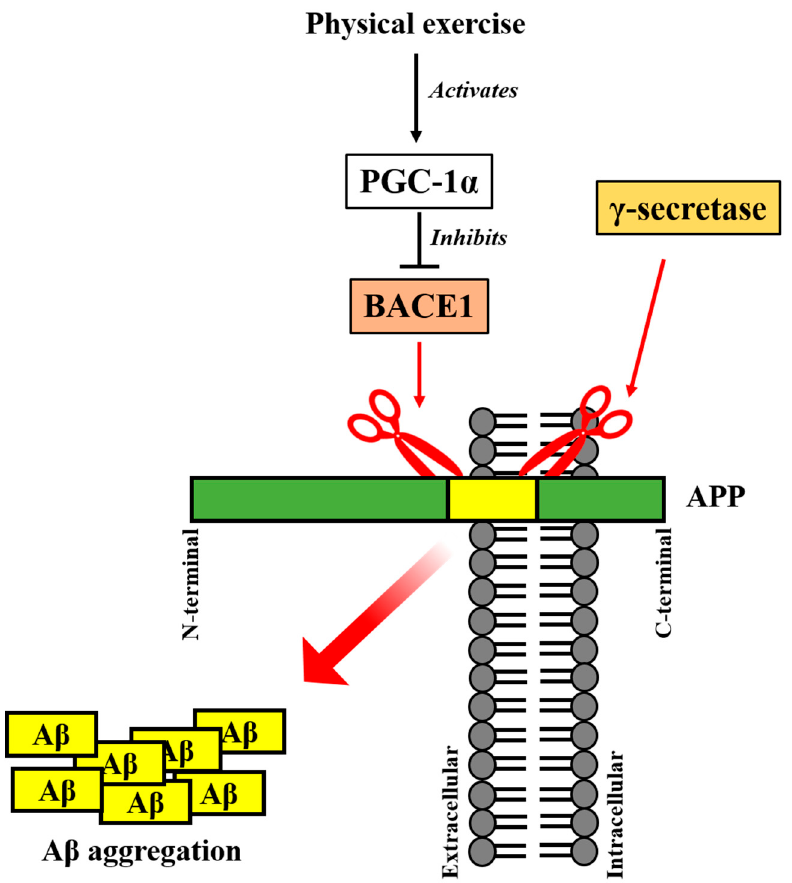
Figure 3. A β accumulation is regulated via reciprocal interactions between PGC-1 α and BACE1. APP is cleaved by BACE1 and γ -secretase followed by A β formation. Accumulated A β affects AD pathogenesis making cells suffer from oxidative stress and cell death. However, PGC-1 α activated by physical exercise blocks BACE1 to generate A β . In this manner, exercise appears beneficial against AD. PGC-1 α , proliferator-activated receptor gamma coactivator 1-alpha; A β , amyloid- β ; APP, amyloid precursor protein; BACE1, beta site APP cleaving enzyme 1.